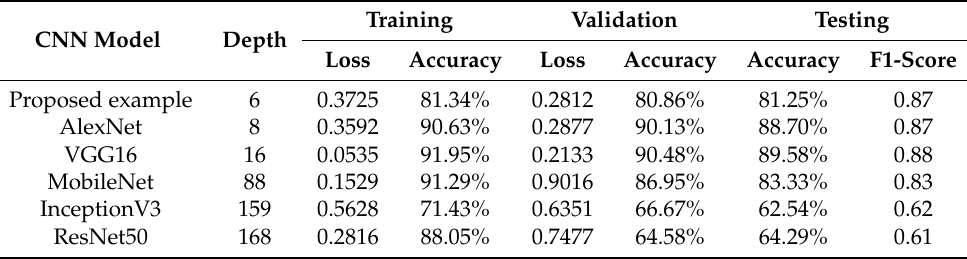
Table 6. Comparison between the proposed example and pre-trained models for fruit quality classification on Apple-NDDA dataset